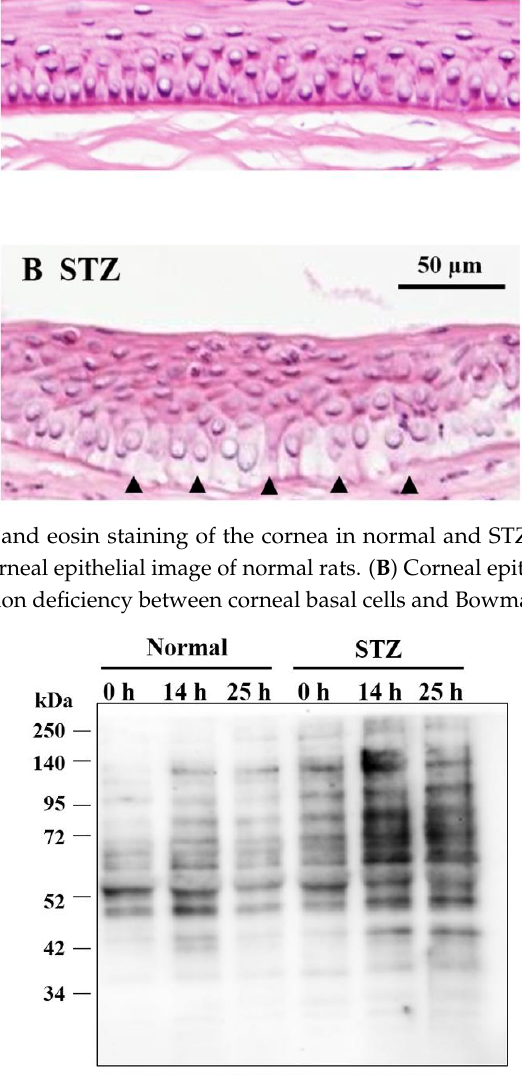
Figure 7. Changes in expression of lumican during the corneal wound healing process. The expression of lumican increased at 14 h in both normal and STZ rats. The high expression level of lumican was still observed in the cornea of STZ rats 25 h after corneal abrasion. β-actin was used as control.